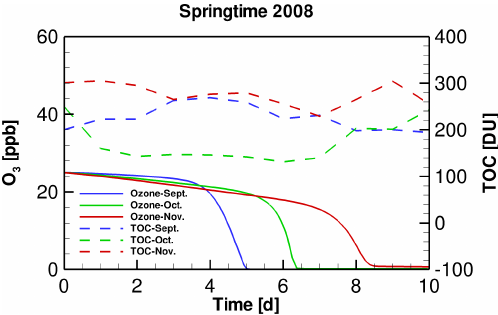
Figure 3. Temporal profiles of TOC in different months of the springtime of 2008 and the simulated surface ozone during